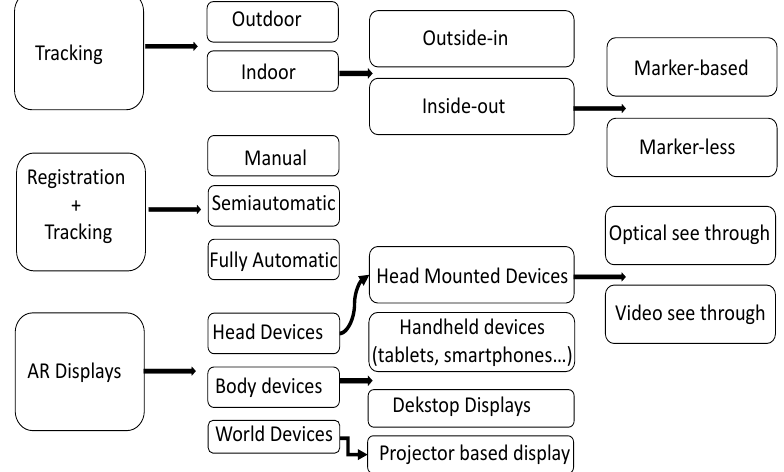
Figure 3. Summary of the